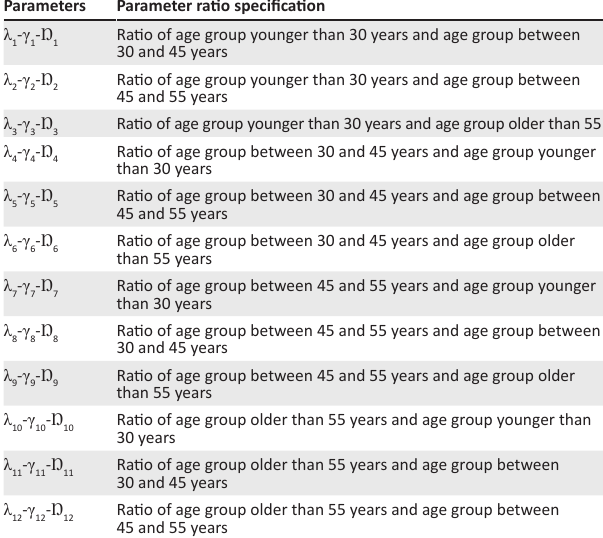
TABLE 2: Specification of the marginal productivity distribution parameter ratios, employee remuneration cost parameter ratios and the net marginal productivity parameter